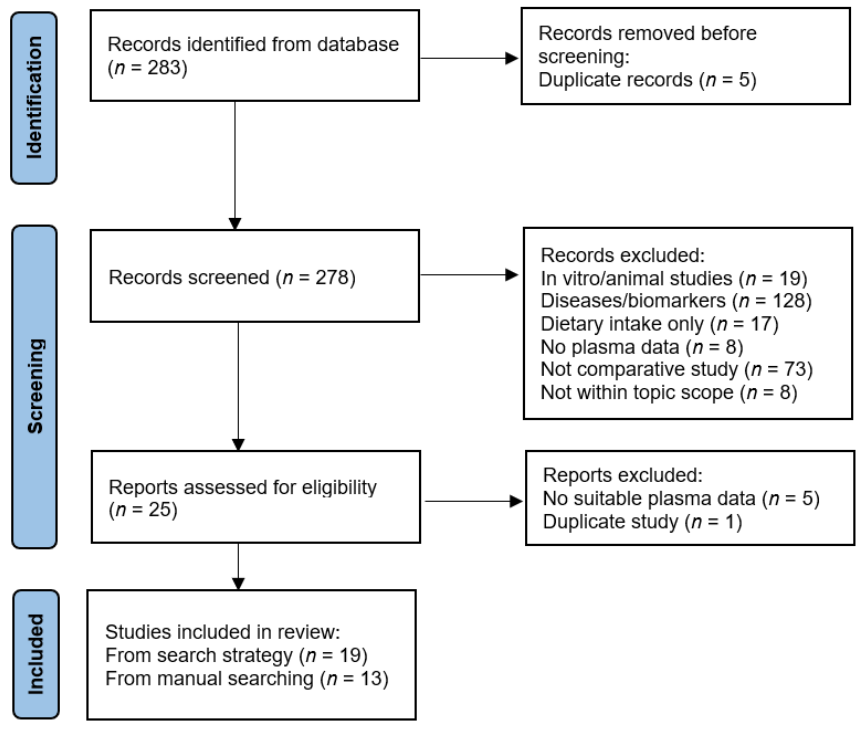
Figure 1. PRISMA flow diagram for study selection.